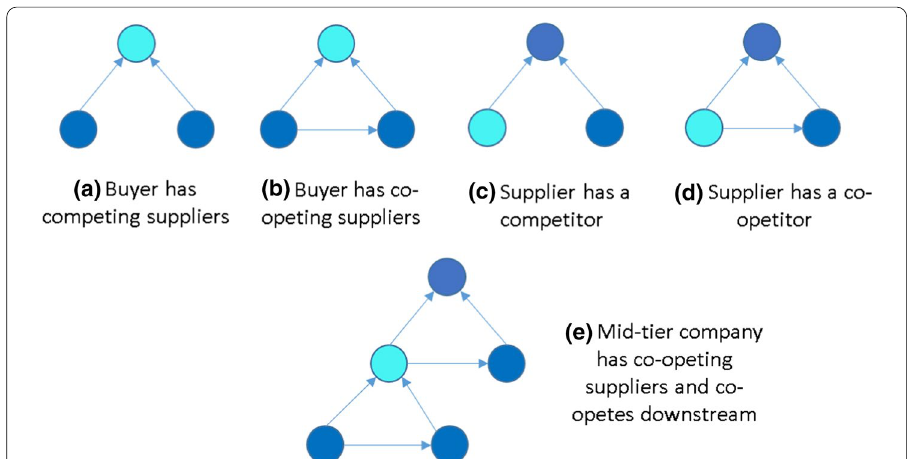
Fig. 2 Upstream and downstream triads in a supply network. Light coloured node is the ego while dark coloured nodes are it’s